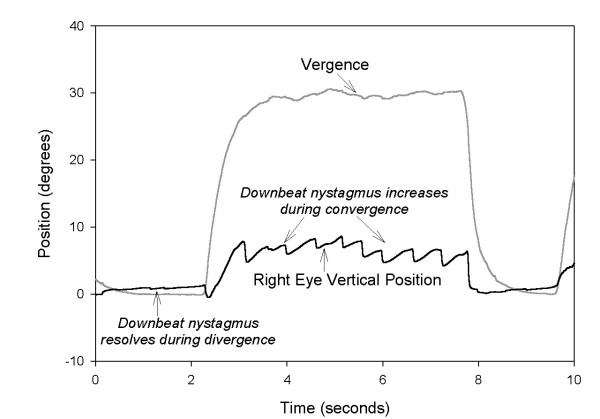
Representative record of downbeat nystagmus in Patient 1, which increased with convergence. Positive values indicated rightward, upward, or convergence movements.